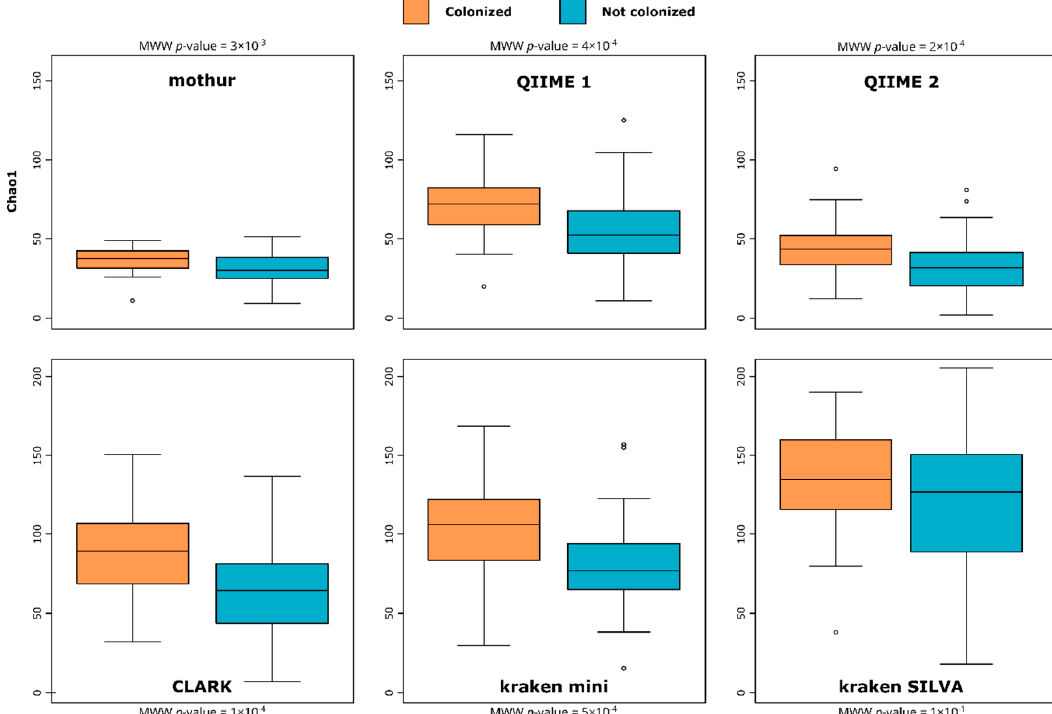
Figure 1. Chao1 indices boxplots at the family level between both groups of patients ( Blastocystis -colonized and Blastocystis -free), for all pipelines. Di ff erence between groups was tested using a Mann–Whitney-Wilcoxon (MWW) test [18,24].